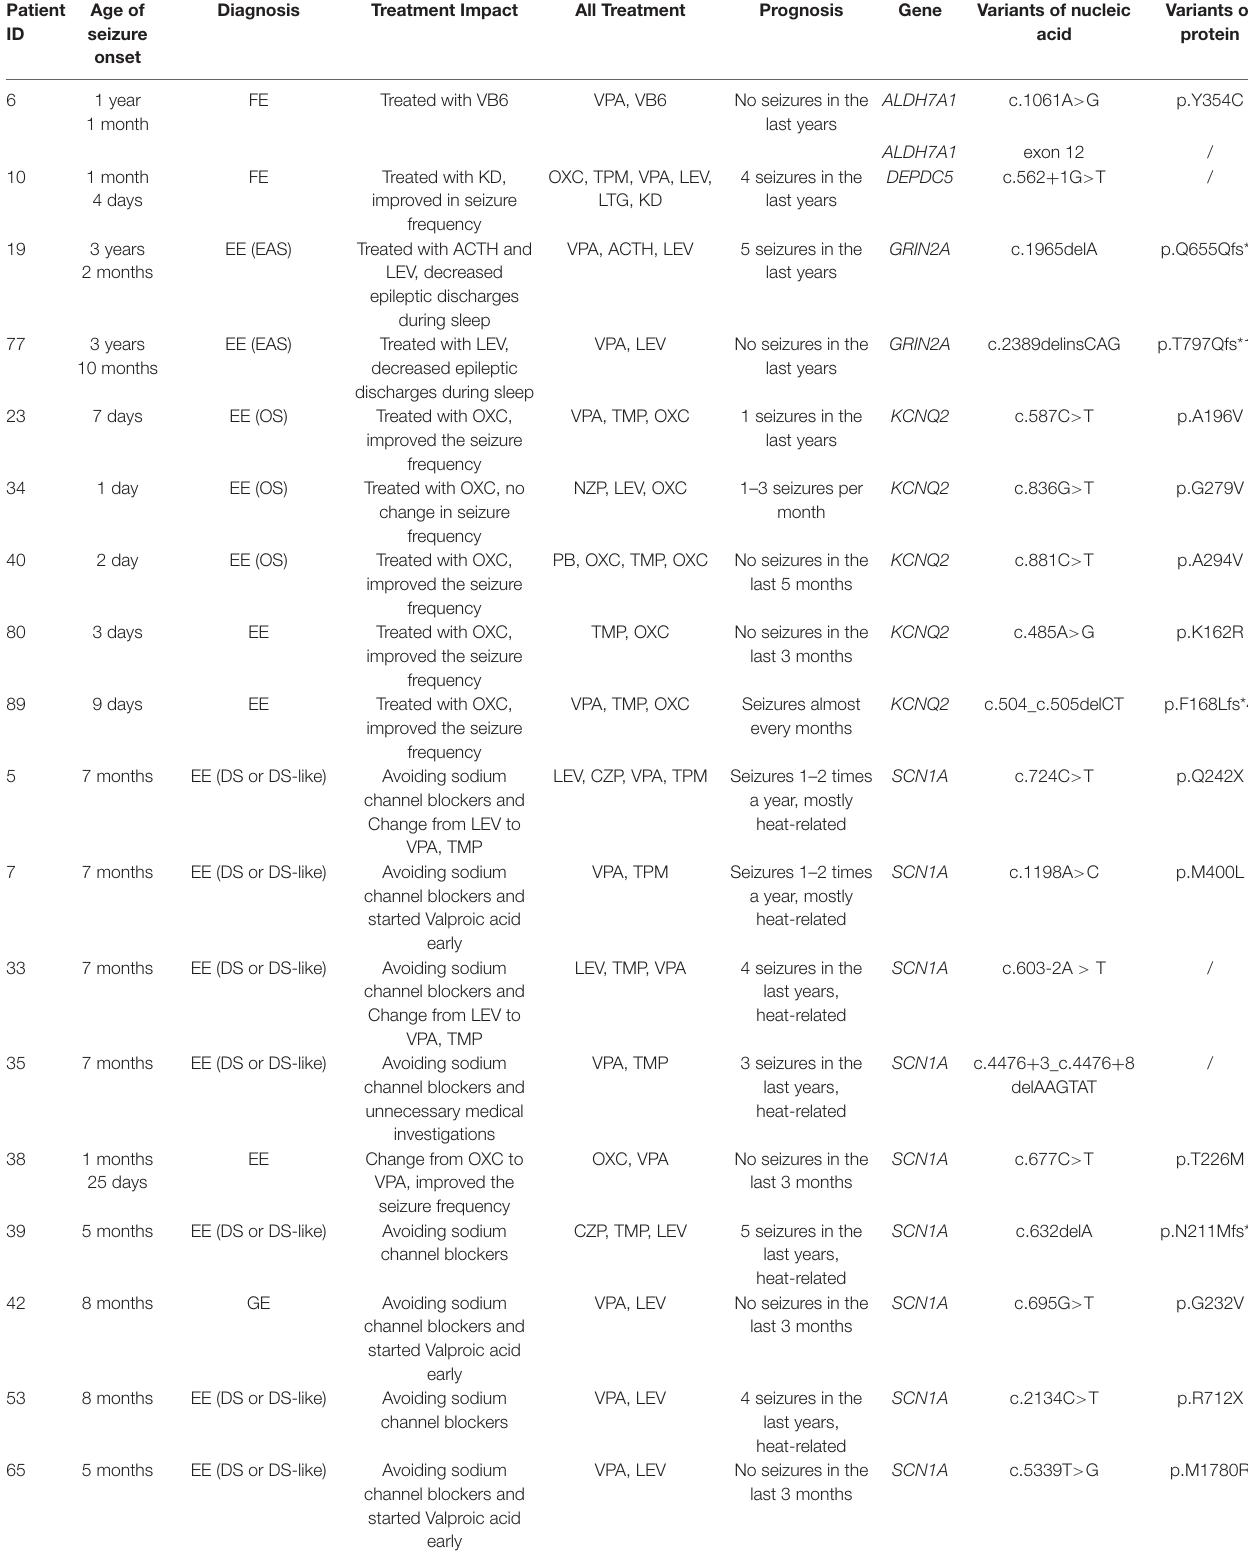
TABLE 5 | Treatment strategies of 32 cases of patients based on WES diagnosis. Patient